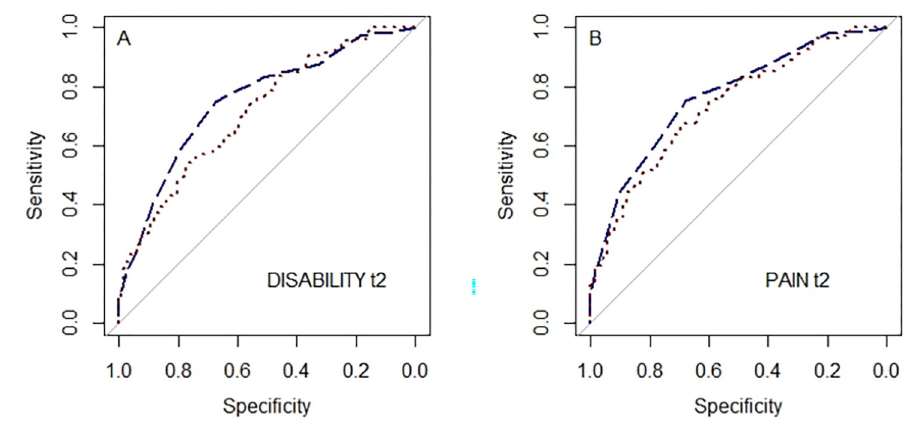
Fig 3. Receiver operating characteristic curves disability and pain at follow-up (t2). Combined DISABILITY score and PAIN versus STarT-MSK G (dashed) and O¨rebro Musculoskeletal Pain Questionnaire (dotted).